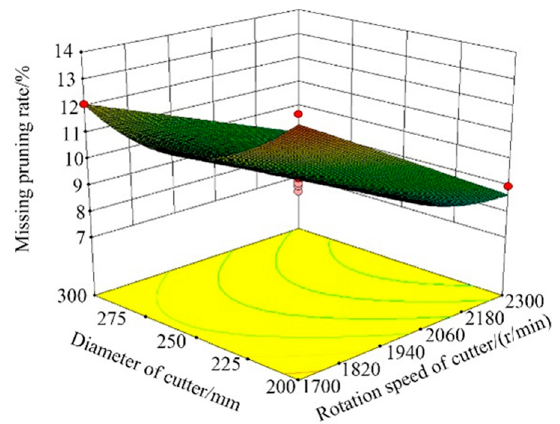
Figure 13. Response surface diagram of the influence of significant interaction factors on the missed pruning rate. pruning